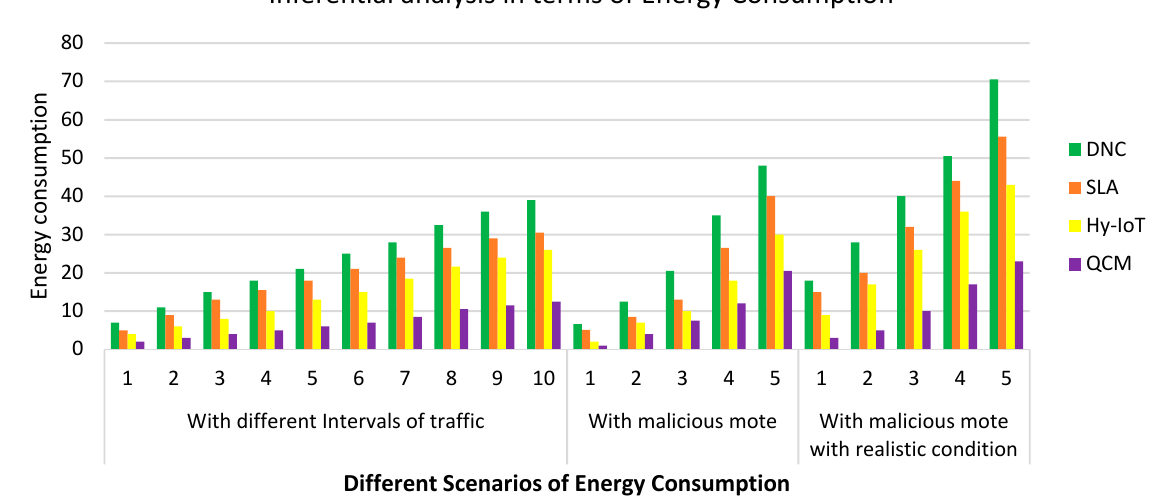
Figure 3. Energy Consumption with respect to different scenarios.